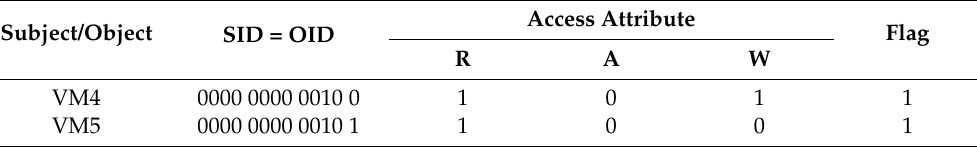
Table 8. Access Matrix of VM4 and